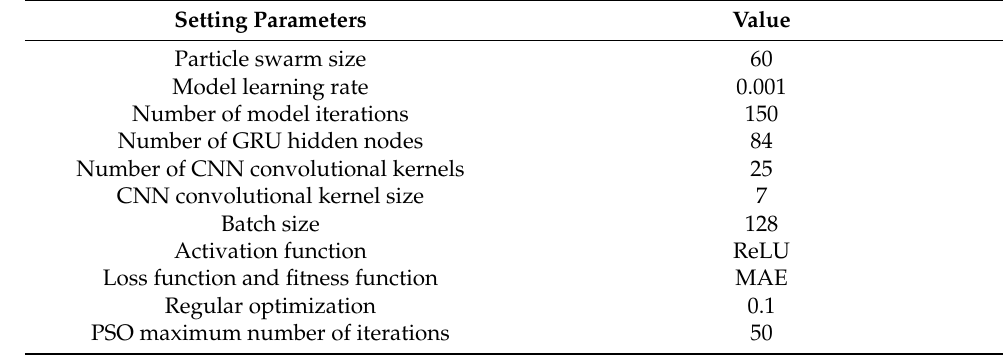
Figure 6. Hyperparameters optimization process of the improved PSO algorithm. Table 3. Initial hyper-parameter settings of the GRU–CNN model based on the PSO algorithm.